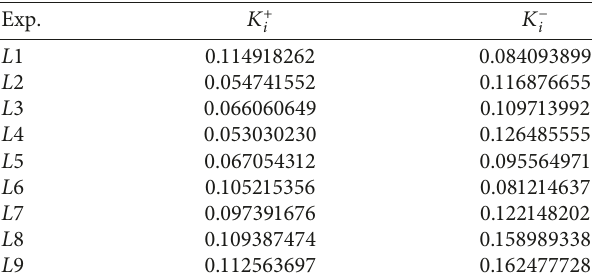
B − i ) and ideal ( i ).